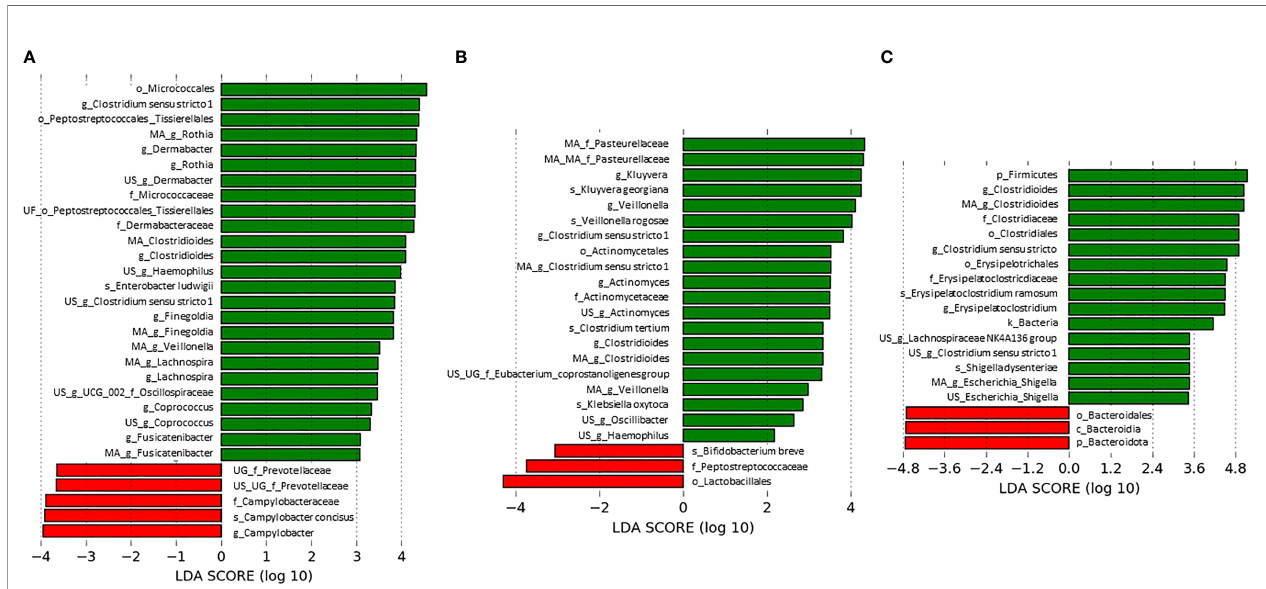
FIGURE 3 | Most differentially abundant taxa associated with C. dif fi cile absence (red) or presence (green) (A) at the sampling time for the ClosNEC dataset, (B) at the sampling time for the EPIFLORE_D28 dataset and (C) at D28 for the EPIFLORE_D7_2 dataset. LDA scores are expressed in log 10 values. Only taxa meeting an LDA signi fi cant threshold > 2 are shown. MA: multi-af fi liation; US: unknown species; UG: unknown genus; UF: unknown family; k: kingdom; p: phylum; c: class; o: order; f: family; g: genus; s: